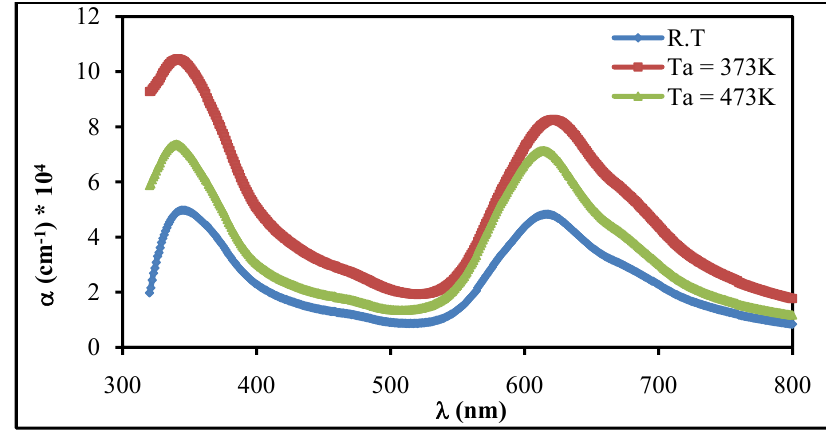
Fig. 3: Absorption Coefficient of as-deposited and annealed NiPcTs thin